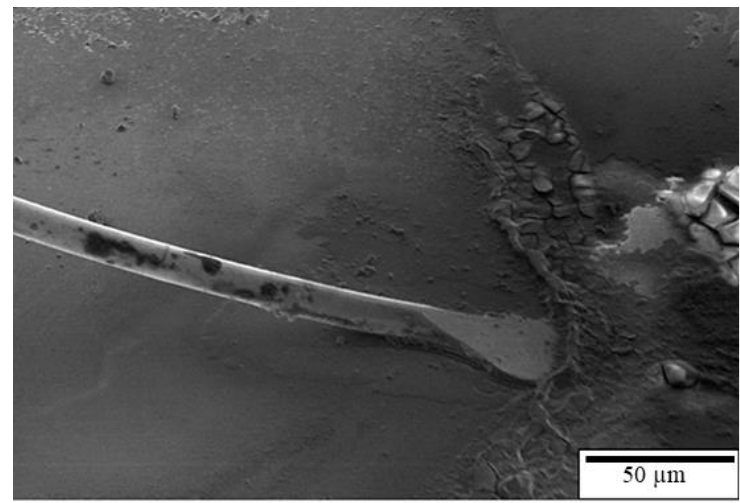
Figure 11. Surface morphology of the second bond of the APAP wire after 30 min of chlorination.